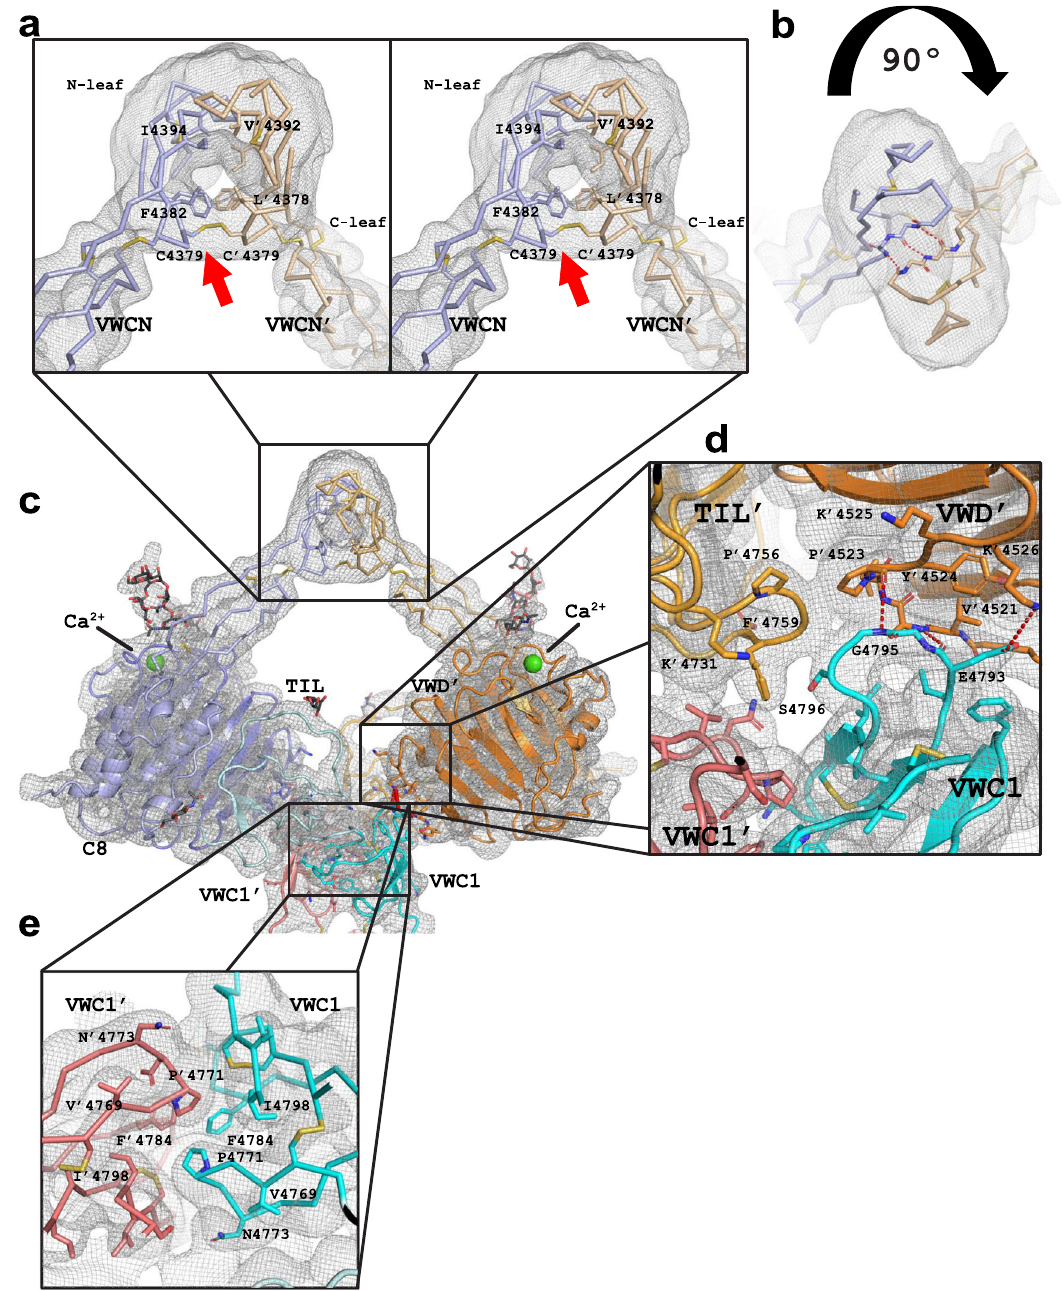
Fig. 2 | The N-terminal globular region of the MUC2-C dimer. a Frontal repre- sentation in stereo of the homodimeric interface of the domain VWCN. The monomers of the dimer are colored in blue and orange. Cryo-EM map is repre- sented as a grey net. The red arrow points to the C4379-C4379 ’ disul fi de bond. b Top view of the homodimeric interface of the domain VWCN. c The globular regionoftheMUC2-C.Inorange,onemonomerwiththedomainsVWCN,VWD,C8, and TIL followed by the N-leaf of the VWC1 of the same monomer, in red. In blue, theothermonomerrepresentingthesamedomainsfollowedbythecorresponding